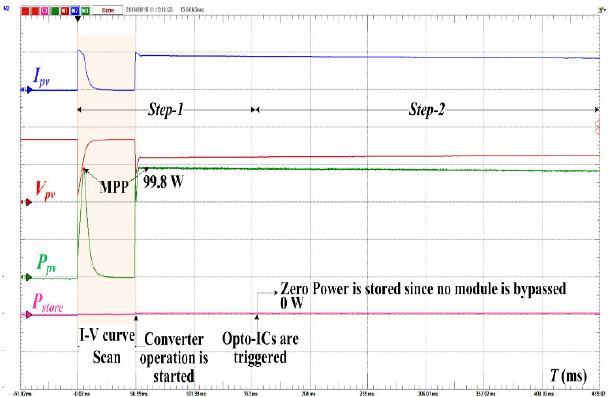
Figure 15 . Experimental result in case 1 .